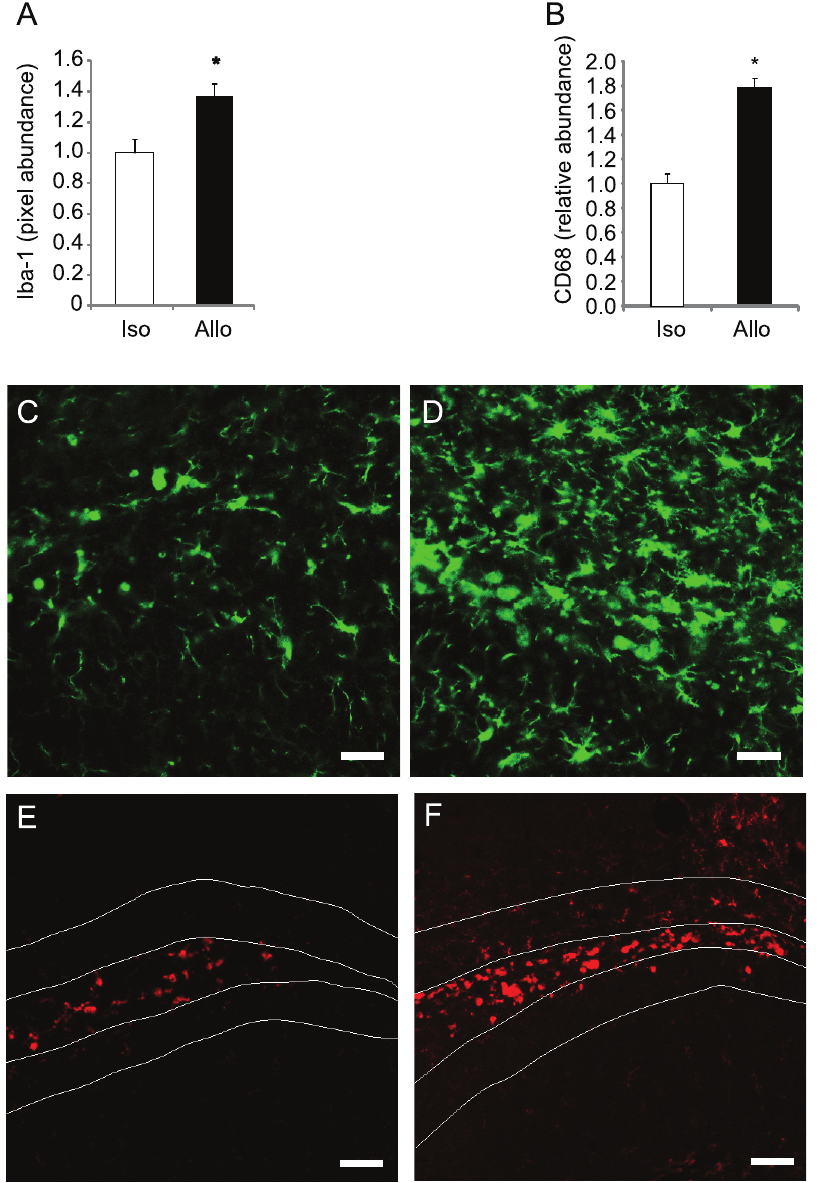
Figure 2. Elevated microglial activation in allografts. Following NPC transplantation, host microglia were stained for Iba-1 and CD68. ( A, B ) Iba-1 and CD68 staining increased in allografts relative to isografts indicating an increase in the number and/or hypertrophy of microglia or monocyte lineage cells (*p , 0.05, n=5). ( C–F ) Representative fluorescent confocal micrographs of isografts (C,E) and allografts (D,F). Iba-1 green in C and D; CD68 red in E and F. Scale bars, 20 m m (C and D) and 50 m m (E and